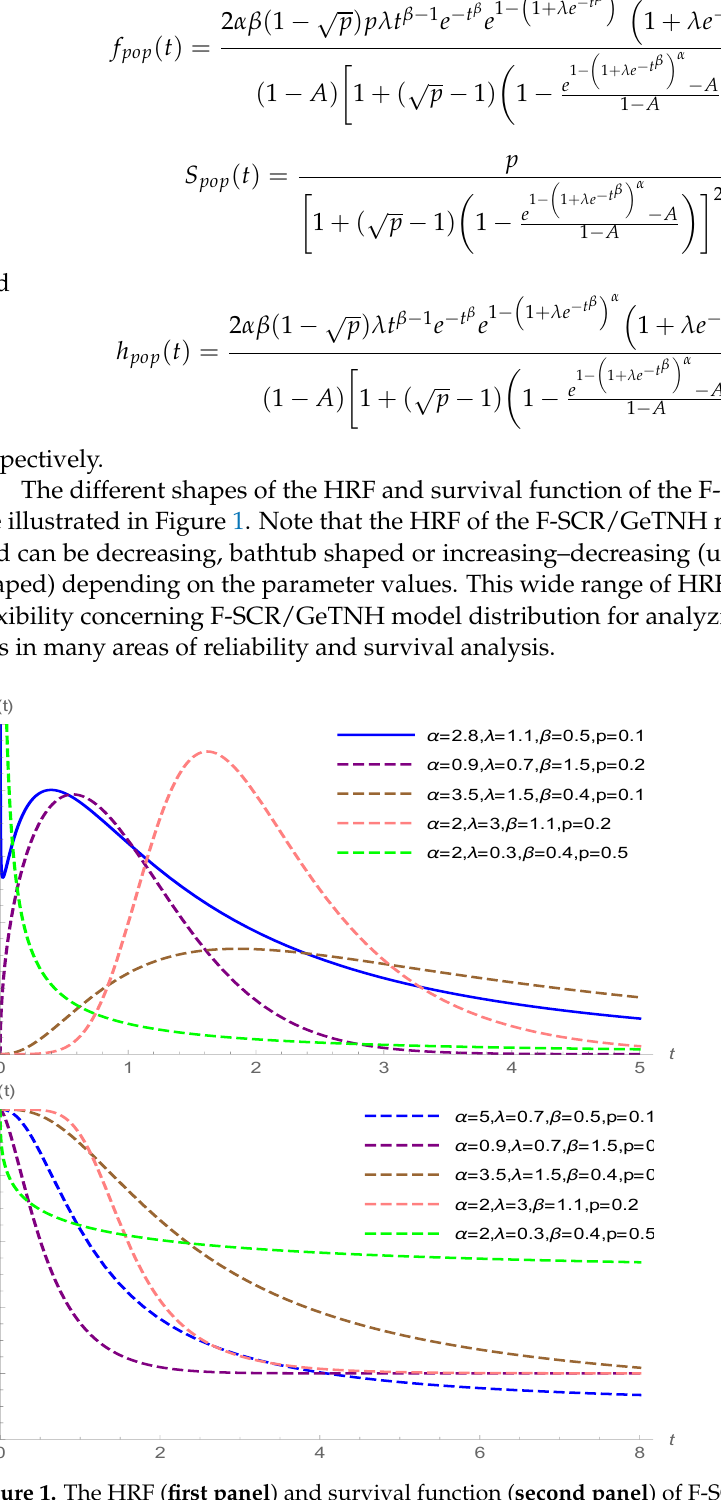
Figure 1. The HRF ( first panel ) and survival function ( second panel ) of F-SCR/GeTNH model for different parameter